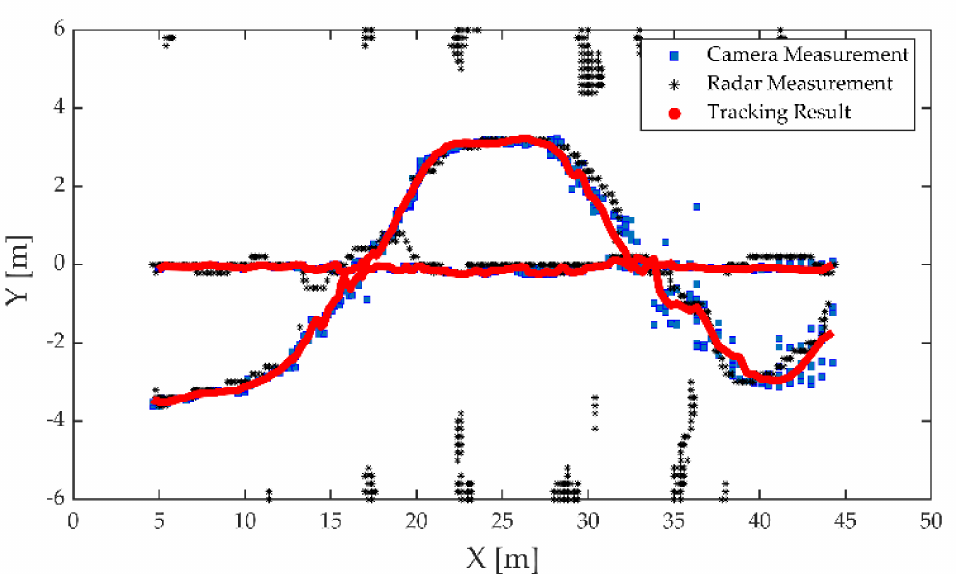
Figure 12. Tracking results for the proposed algorithm based on the radar and camera fusion